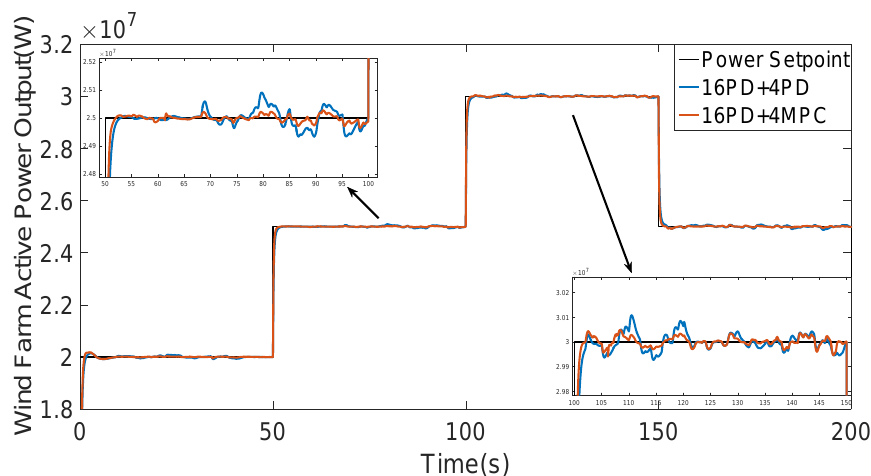
Figure 14. Wind farm power output under a step changes power demand.